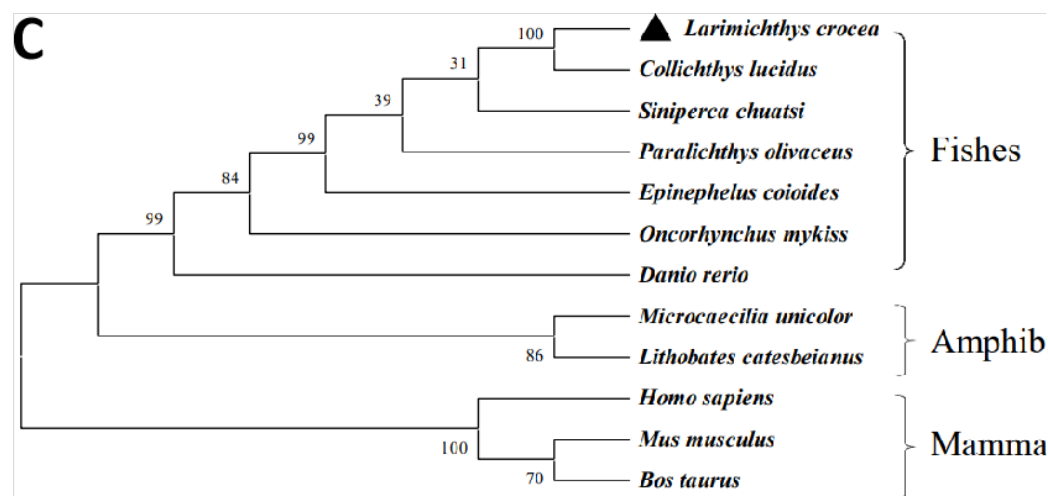
Figure 1. ( A ) Multiple sequence alignment of ASC from different species. Gray shading denotes some charged residues for mammalian PYD or CARD fibrillation. The underline represents α -helix structure. ( B ) Tertiary structure of LcASC protein containing twelve α -helix structures. ( C ) The phylogenetic tree of LcASC.